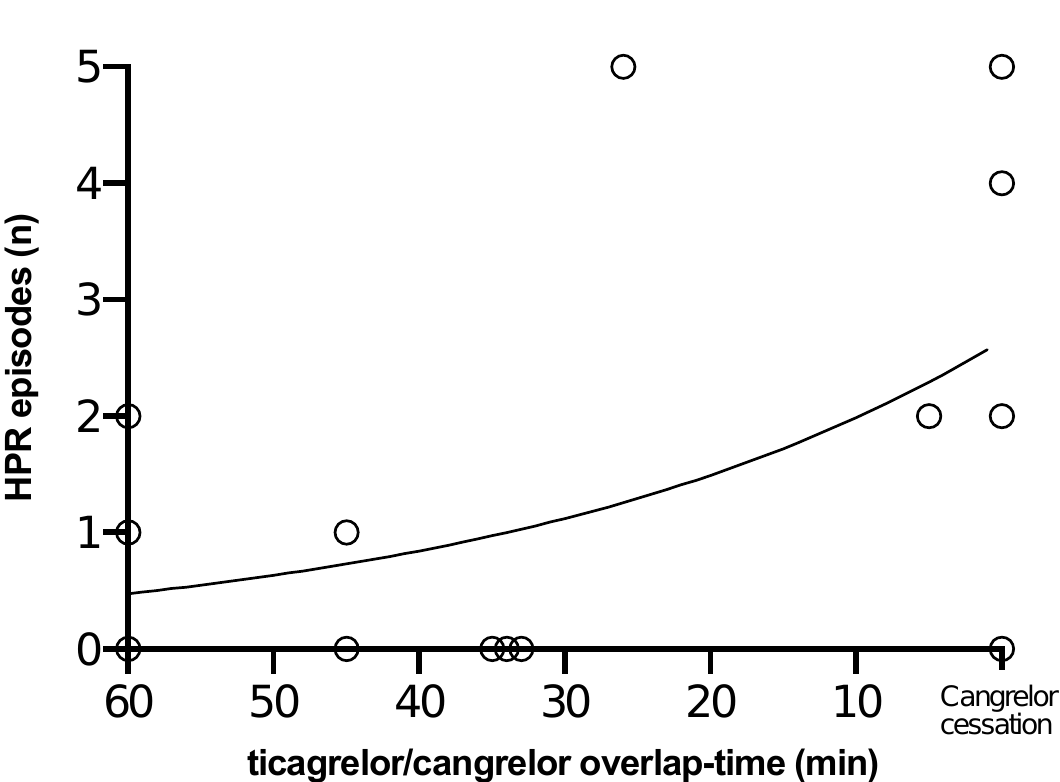
Figure 4. Relationship between the overlap time of cangrelor and ticagrelor co-administration (x-axis) and the number of high platelet reactivity (HPR) episodes after cangrelor cessation (y-axis). HPR episodes significantly increased with decreasing ticagrelor/cangrelor overlap time.